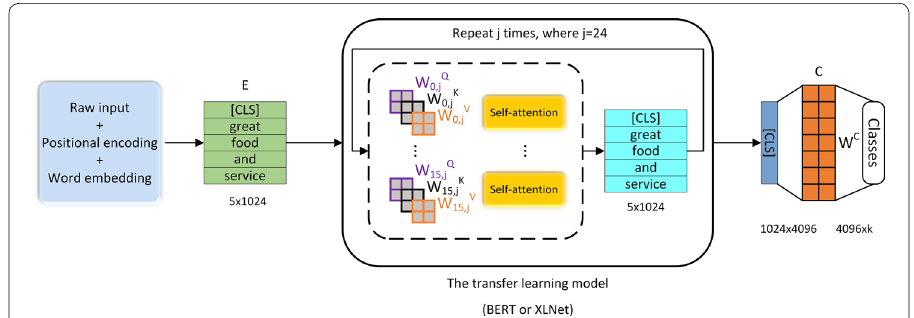
Fig. 4 The analytical pipeline of the proposed